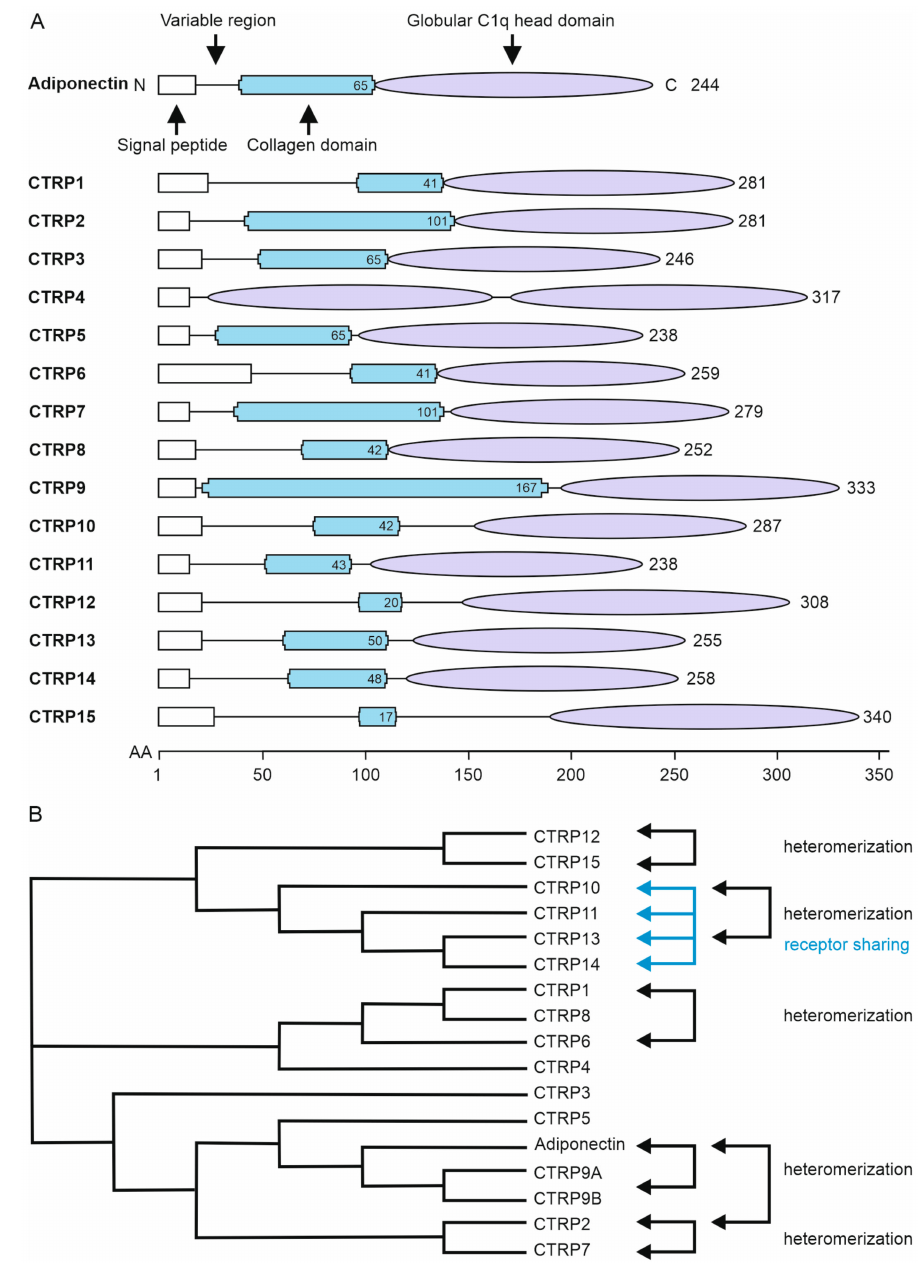
Figure 1. Domain architecture ( A ) and homology comparison ( B ) of CTRP family members. ( A ) CTRPs are characterized by a signal peptide (white) and a variable domain at the N terminus with conserved cysteine residues followed by a collagen domain (blue, the given number corresponds to the amino acid length of the collagen domain). As an exception, CTRP4 is lacking a collagen domain. At the C-terminus CTRP family members have a globular C1q head domain (purple) enabling trimerization. This domain is structurally related to the tumor necrosis factor (TNF) homology domain (THD) of ligands of the TNF superfamily (TNFSF) and the complement component C1q. Please note, in case of CTRP4 there are two C1q head domains. The number of amino acids of the CTRPs is indicated at the C terminus. ( B ) Cladogram of full-length CTRP family members. Strikingly, CTRP family members with a higher degree of sequence homology appear to form heteromers among each other. The same applies to CTRPs that share the same receptor. The cladogram was generated by multiple sequence alignment of protein sequences using ClustalW